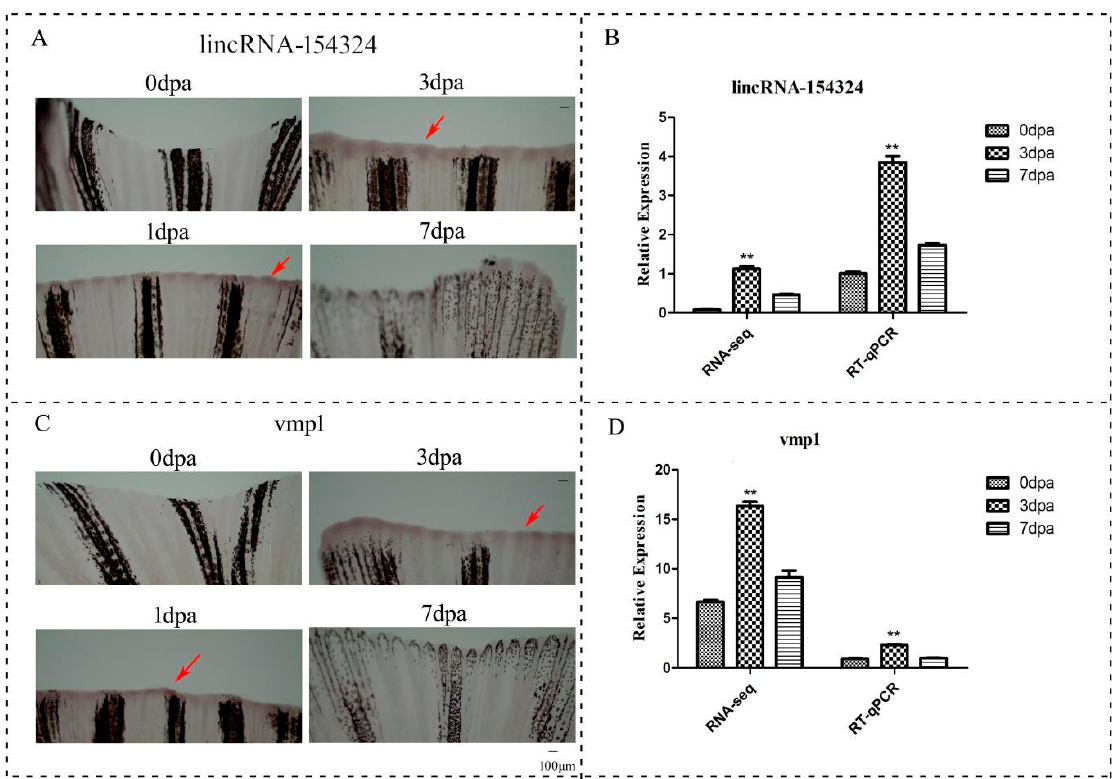
Figure 7. The temporal and spatial expression of lincRNA-154324 and vmp1 in caudal fin regeneration. ( A ) 0 dpa–7 dpa: lincRNA-154324 spatial expression in zebrafish caudal fin for different processes of regeneration, as shown using WISH. Red arrow: pointing to the positive site. Scale bars: 100 μ m. ( B ) The relative expression of lincRNA-154324 in caudal fin regeneration, as shown using RT-qPCR and RNA-seq. Data (mean ± SEM) are representative results derived from three independent experiments. (**) p < 0.01, when comparing to 0 dpa. ( C ) 0 dpa–7 dpa: vmp1 spatial expression in zebrafish caudal fin regeneration, as shown using WISH. Red arrow: pointing to the positive site. Scale bars: 100 μ m. ( D ) The relative expression of vmp1 in caudal fin regeneration, as shown using RT-qPCR and RNA-seq. Data (mean ± SEM) are representative results derived from three independent experiments. (**) p < 0.01, when comparing to 0 dpa.